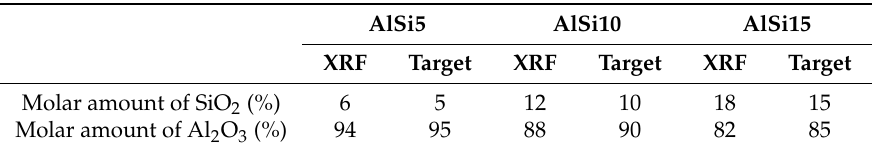
Table 1. Chemical composition of the prepared materials.